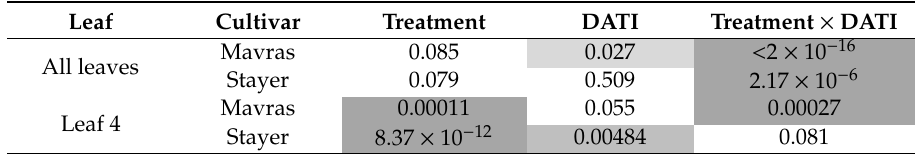
Figure 4. Temporal development of secondary metabolites in leaves of bell pepper cultivars “Mavras” and “Stayer”, expressed with the FLAV-index (Multiplex). ( C ), ( D ), n = 5; ( A ), ( B ), n = 5–50; DATI, day after treatment initiation. Table 2. Interaction and main e ff ect for treatments (control, salt-stress, combined-stress, UV-stress) and DATI (0, 2, 7, 9, 15). To account for the unbalanced design (e.g., unequal numbers of observations within each level of DATI), type III ANOVA was selected to compare di ff erences between factor means for FLAV values of “All leaves”. Grayed area indicates significant e ff ect at p ≤ 0.05 (light), p ≤ 0.01 (medium), and p ≤ 0.001 (dark).